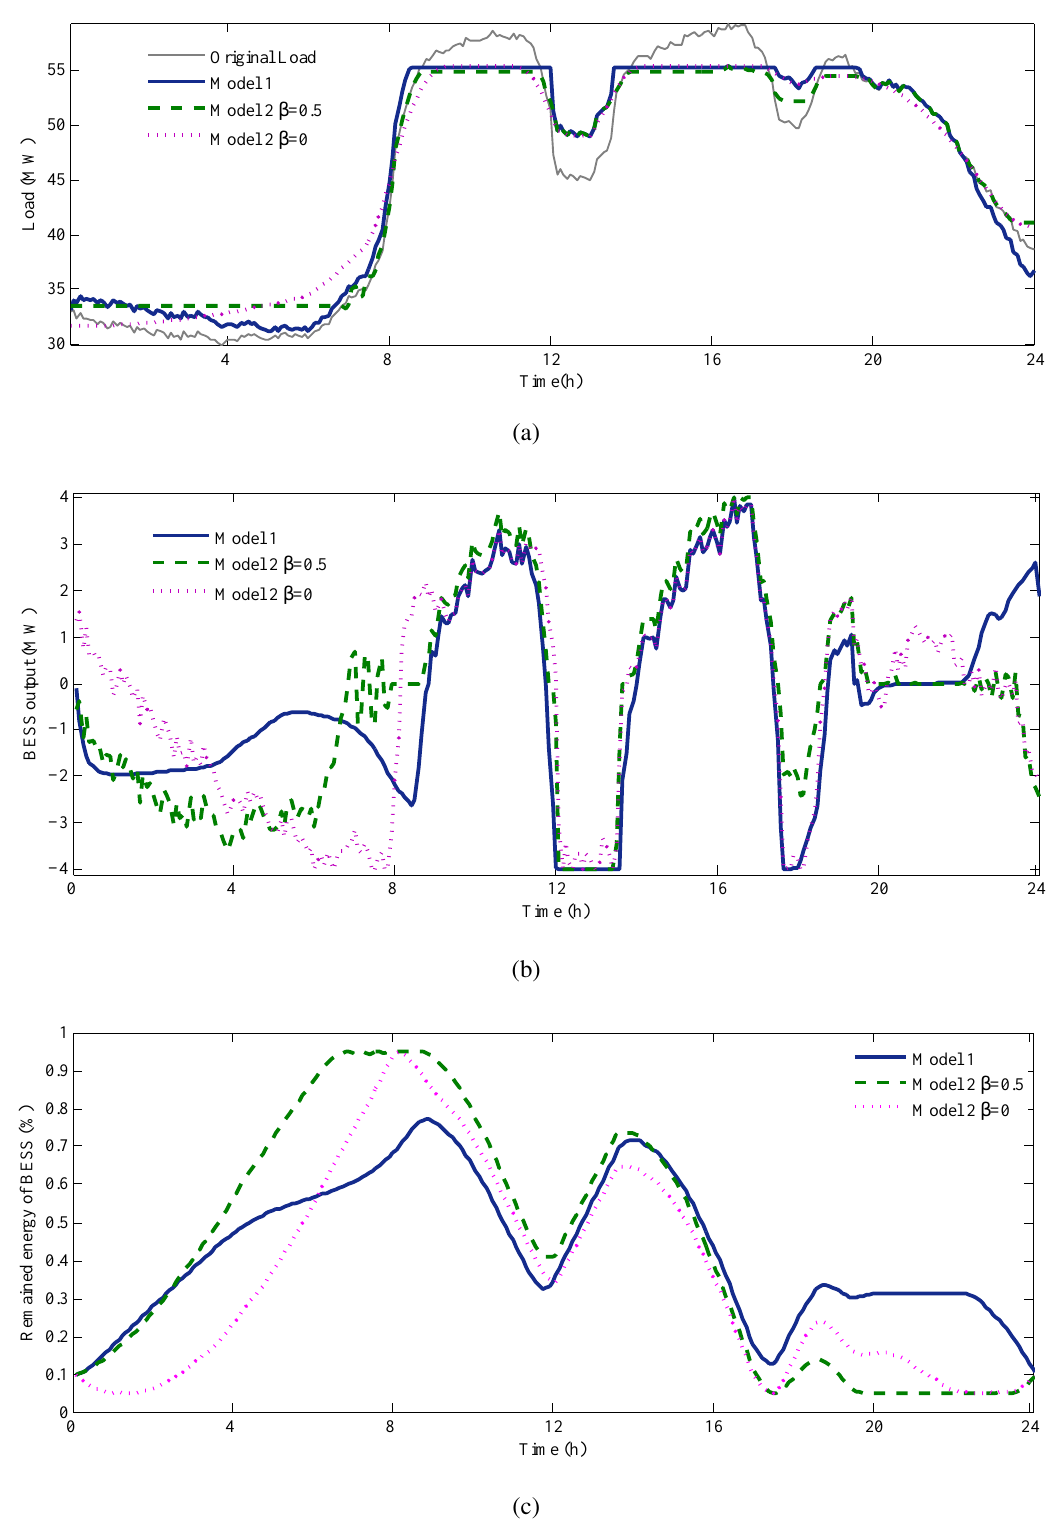
Figure 7. Optimal load shaving results under different models. ( a ) Load curve; ( b ) BESS output; ( c ) Remaining